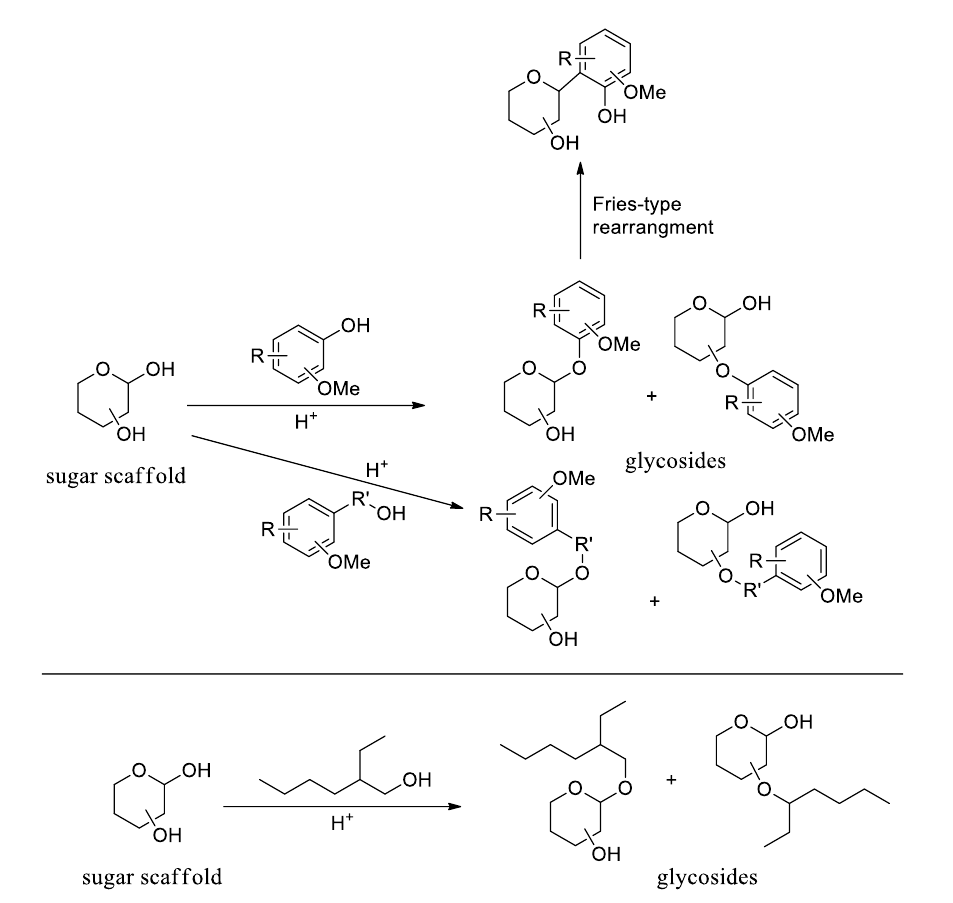
Figure 5. Mechanism of glycoside formation from alkylphenolic moieties (above), and glycoside formation from 2-ethylhexanol (below).